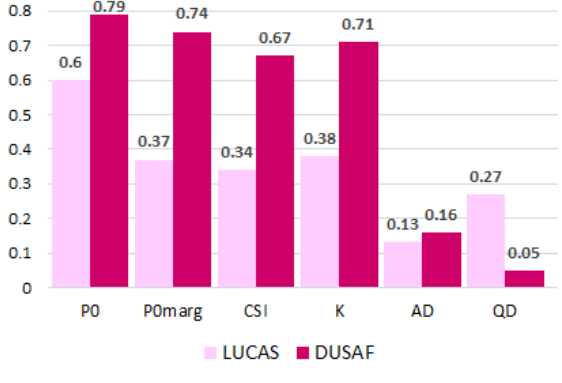
Figure 3. Global accuracy indexes for Lombardy